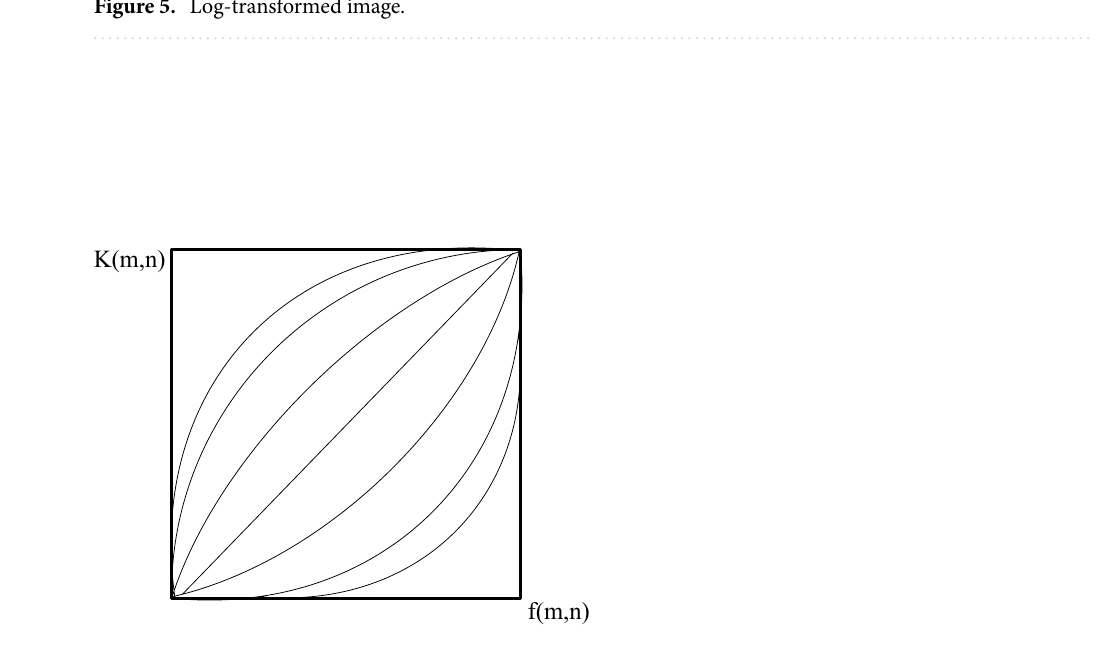
Figure 6. Power-transformed